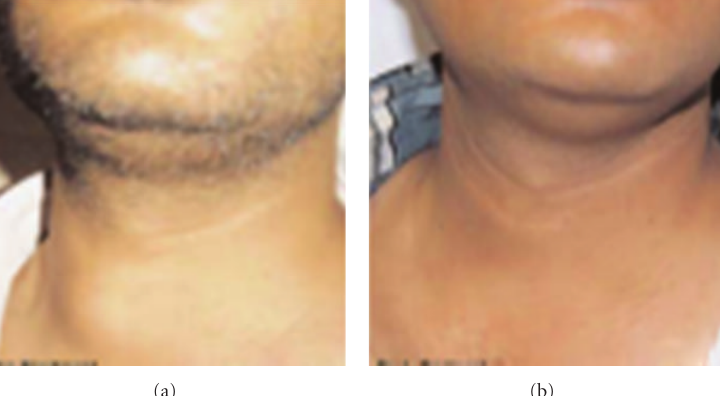
Figure 2: (a) Large solitary nodule over the right lower neck before treatment. (b) Complete resolution of the swelling after anti-tuberculous